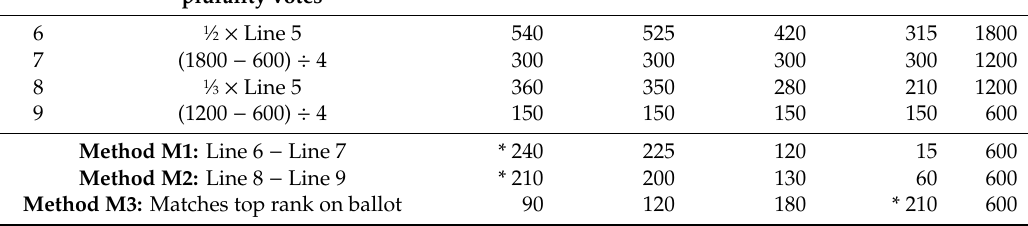
Table 8. Details for Hare system for North Dakota (2024 election, Scenario 3). Total Votes for Hare Rounds (Lines 6–10) or Derived Values and Pseudo Plurality Votes (Rest of Table), in Thousands,